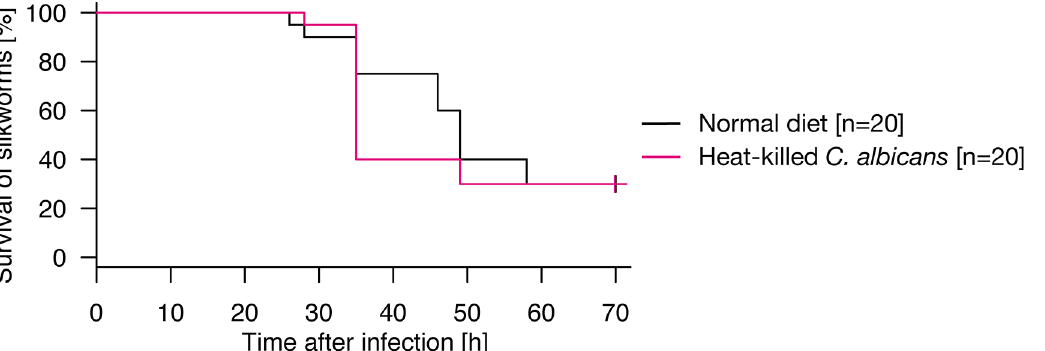
Fig 3. Resistance of silkworms orally administered heat-killed fungi against fungal infection. Silkworms were fed a normal diet (n = 20) or a diet containing heat-killed C . albicans cells (n = 20) for 2 d, and then injected with C . albicans . Results from two independent trials (S1 Table, exp. 7 – 8) were combined into a single analysis. The combined survival curve is shown in the figure. Survival of silkworms fed the diet containing heat-killed C . albicans cells was comparable to that of silkworms fed the normal diet (p = 0.995). None of the mock-infected silkworms died (S1 Fig).